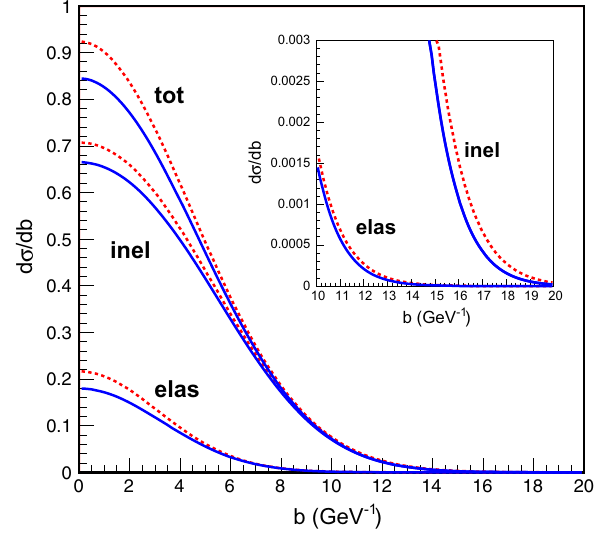
√ s = 8 TeV, with solid